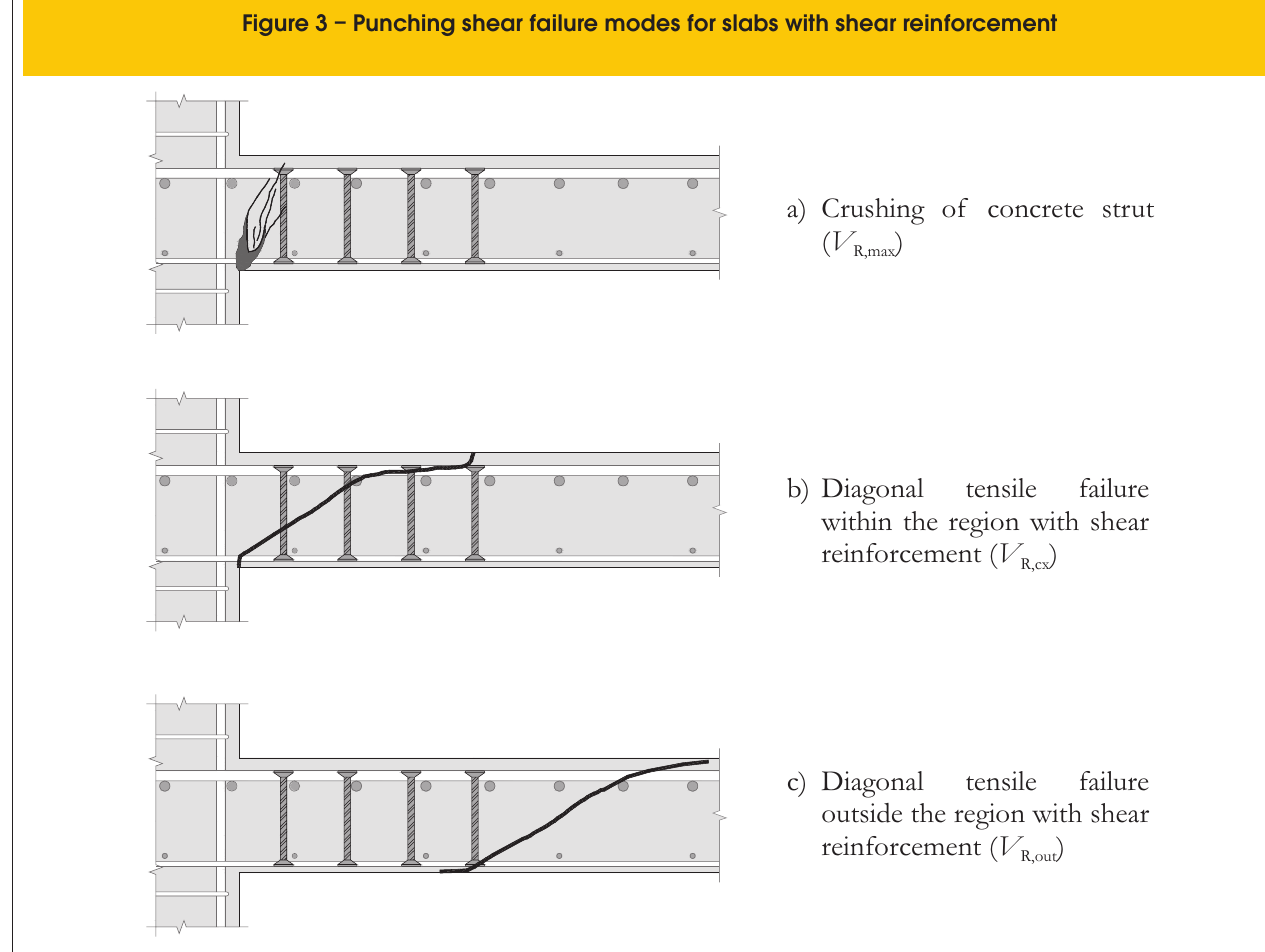
Figure 3 – Punching shear failure modes for slabs with shear